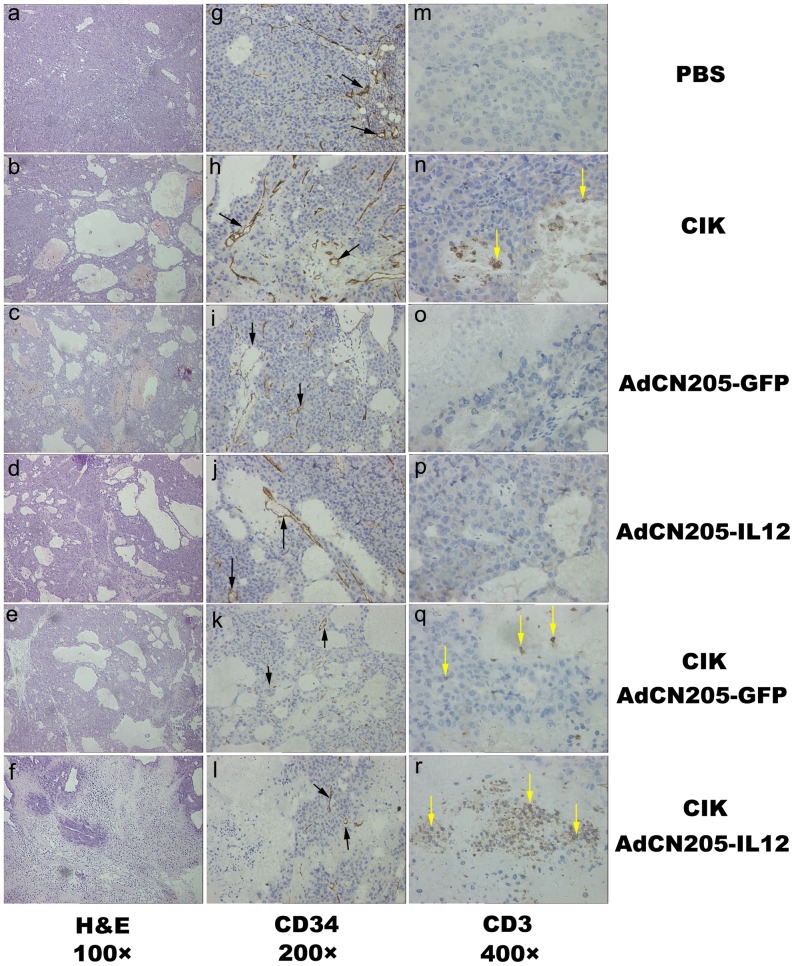
Histologic analysis of tumor sections from the mice that were treated with PBS (a, g, and m); CIK (b, h and n); AdCN205-GFP (c, i and o); AdCN205-IL12 (d, j and p); CIK combined with AdCN205-GFP (e, k and q) or CIK combined with AdCN205-IL12 (f, l and r).a to f, H&E staining of tumor sections, showing the areas of necrosis in tumors. Original magnification, 100×. g to l, Immunohistochemical analysis of tumor blood vessel in tumor sections using anti-mouse CD34 antibody staining (black arrow). Original magnification, 200×. m to r, Immunohistochemical analysis of human CIK cells in tumor sections using anti-human CD3 antibody staining (yellow arrow). Original magnification, 400×.